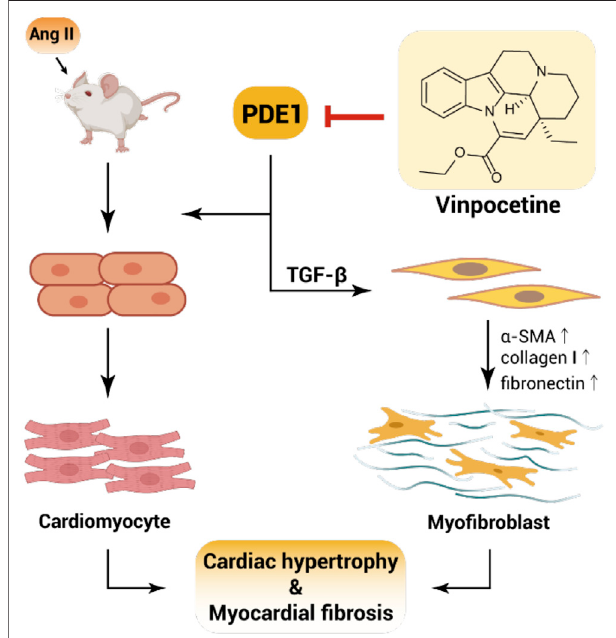
FIGURE 4 | Vinpocetine attenuates Ang II-induced cardiac hypertrophy and myocardial fi